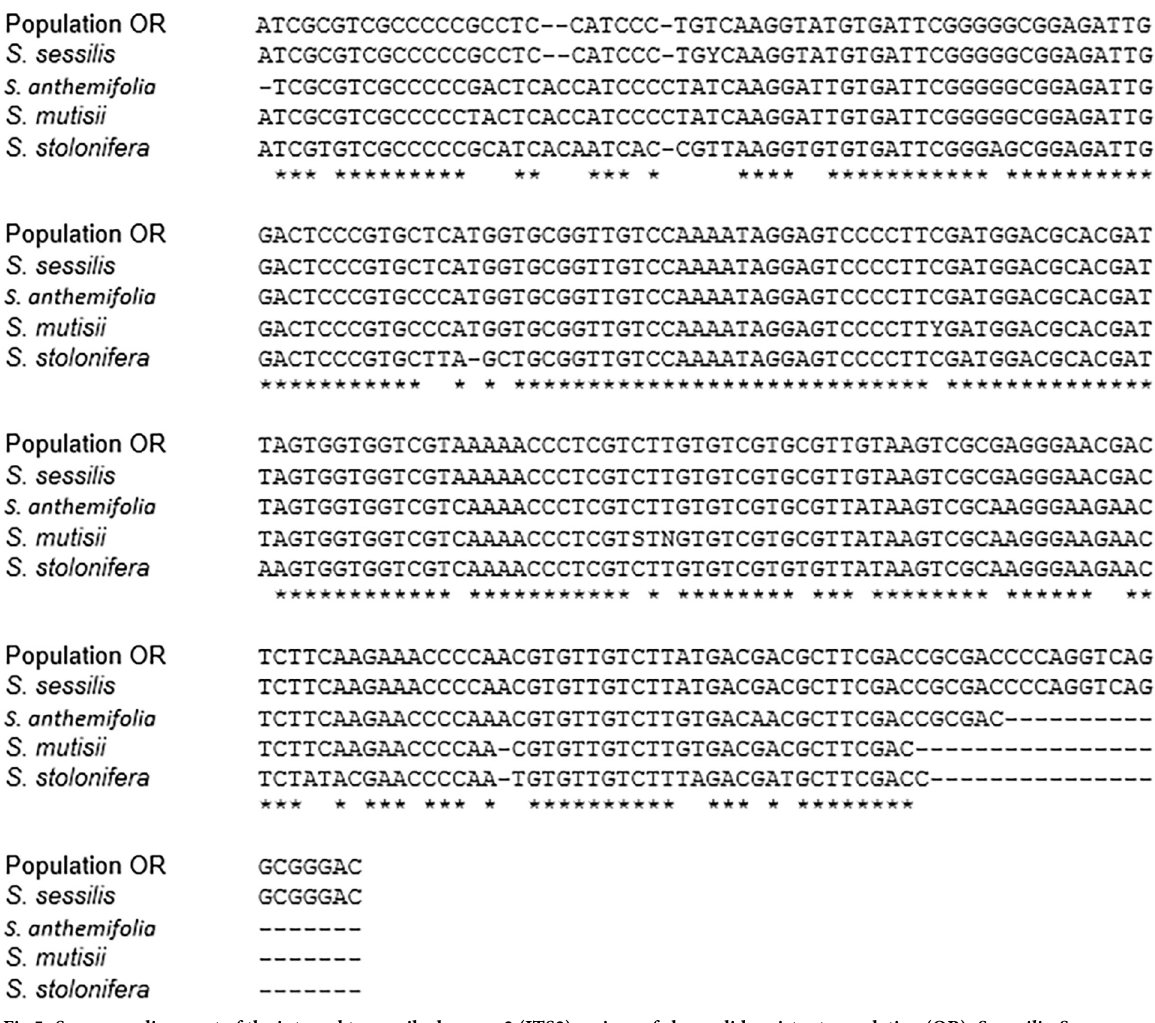
Fig 5. Sequence alignment of the internal transcribed spacer 2 (ITS2) regions of clopyralid-resistant population (OR), S . sessilis , S . anthemifolia , S . mutisii and S . stolonifera . Hyphens (-) denote alignment gaps and asterisks donate residues conserved in all sequences.